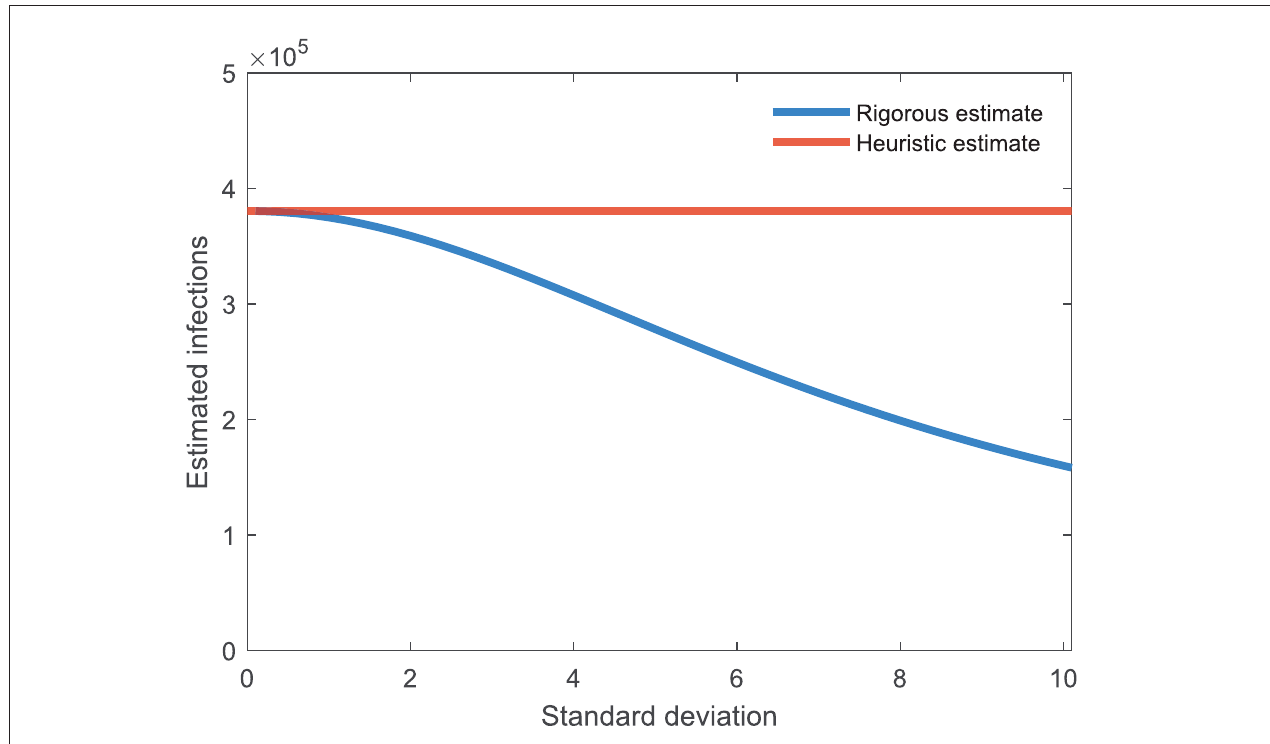
FIGURE 1 | Not accounting for the standard deviation in time from infection to death can lead to large estimation error. The blue curve shows the estimated number of infectives assuming that the time from infection to death is lognormally distributed with mean 21 days and standard deviation given by the horizontal axis. The heuristic estimate using Equation 1, shown as the red curve, underestimates the actual number up to four times. Other parameters: exponential doubling time T = 4, number of deaths d = 100, and infection fatality ratio p = 0.01 (i.e., 1%).